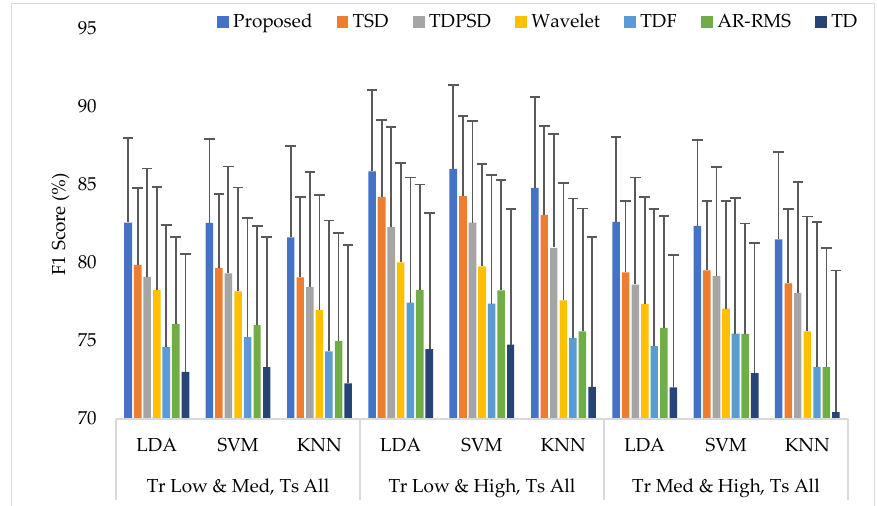
Figure 8. The EMG pattern recognition performances when the training forces are two and the testing forces are three, where Tr and Ts indicate training and testing, respectively.